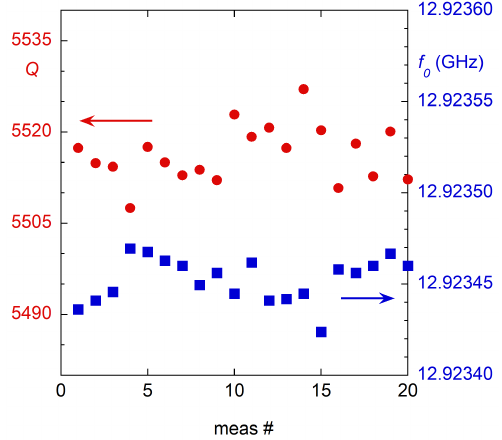
Figure 7. Q (red circles) and f 0 (blue squares) measurement repeatability evaluation.